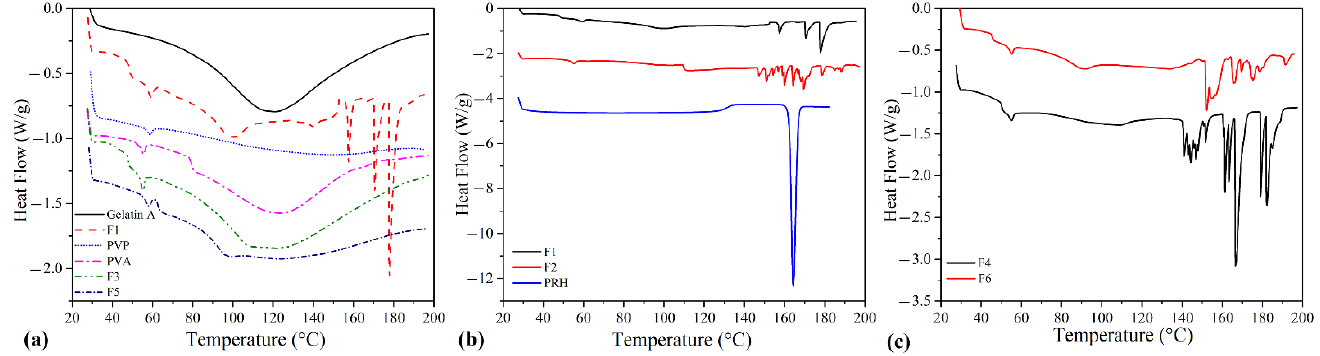
Figure 2. DSC thermograms of ( a ) Gelatin A, F1, PVP, PVA, F3, and F5; ( b ) F1, F2, and PRH; and ( c ) F4 and F6. Endothermic peaks in the range 140–185 ◦ C are present in thermograms of